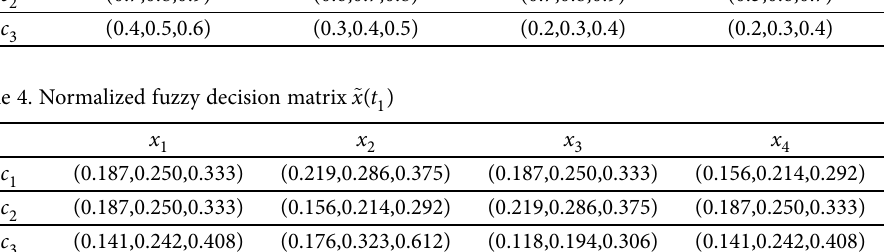
Table 3. Fuzzy decision matrix x ( t